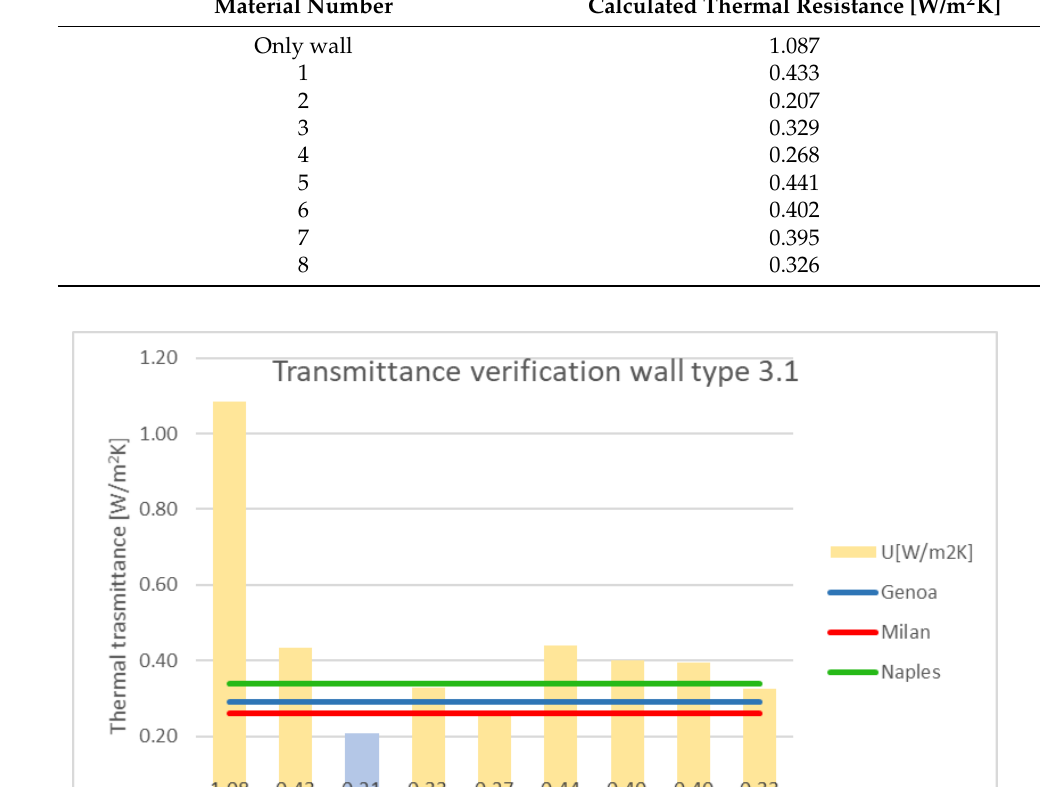
Figure A7. Wall type 3.2: stratigraphy with thicknesses and conductivities for the different layers. The numbers start from the outside.